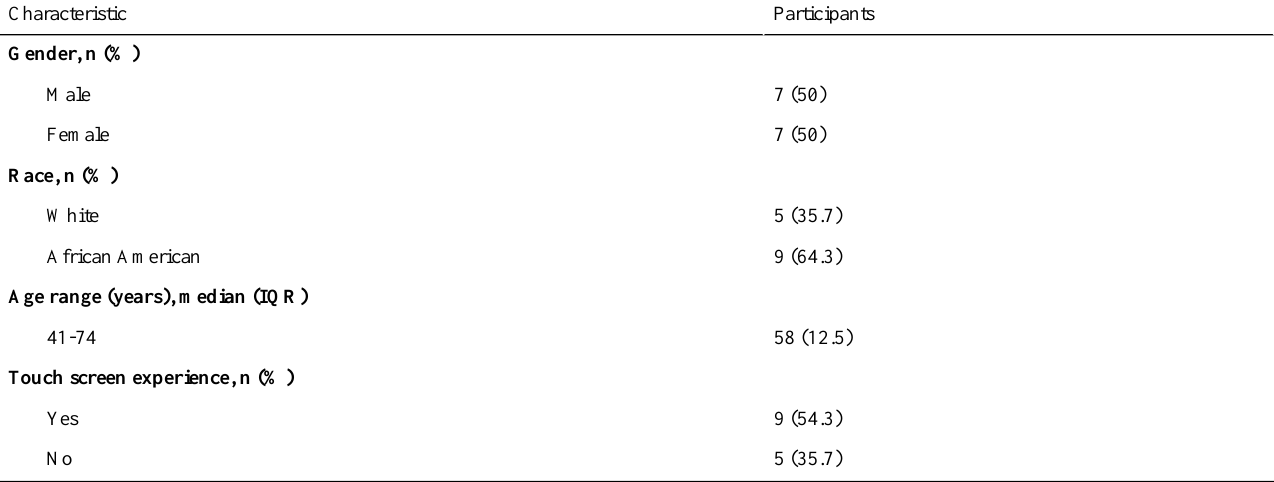
Table 1. Study demographics of patients undergoing hemodialysis (N=14) and their experience in using touch screen devices.